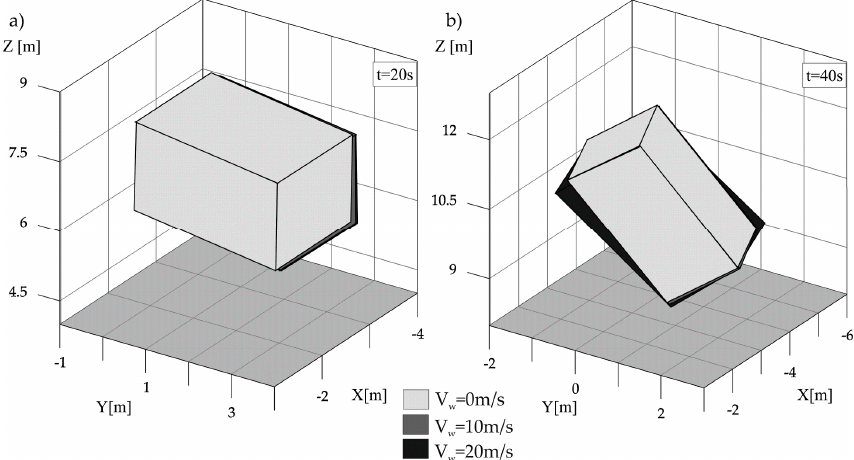
Figure 25. Load orientation in particular moments of time (wind power having impact according to the direction of the X axis). ( a ) t = 20 s, ( b ) t = 40 s.